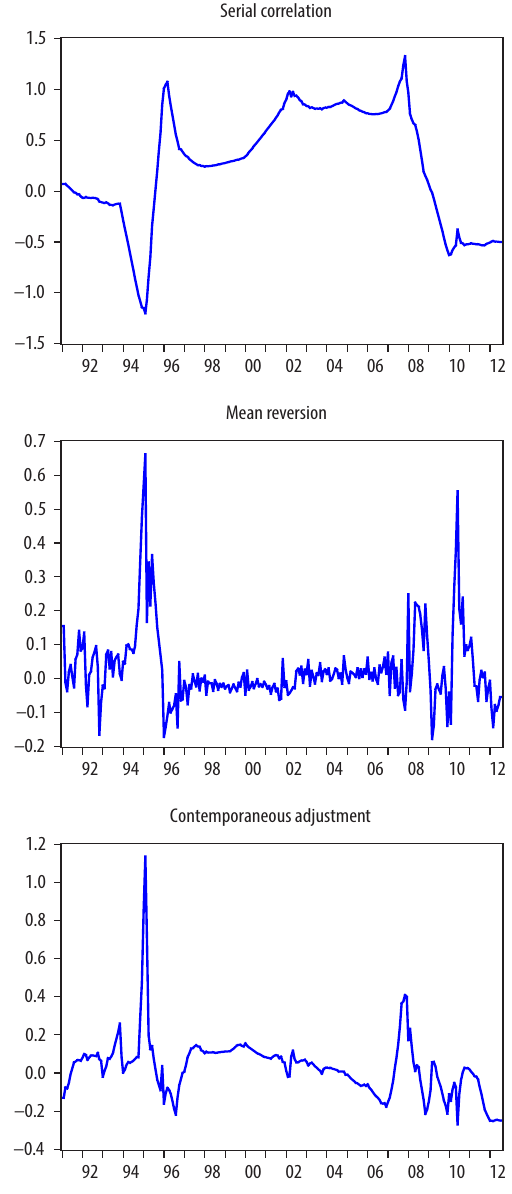
Fig. 3. Time varying